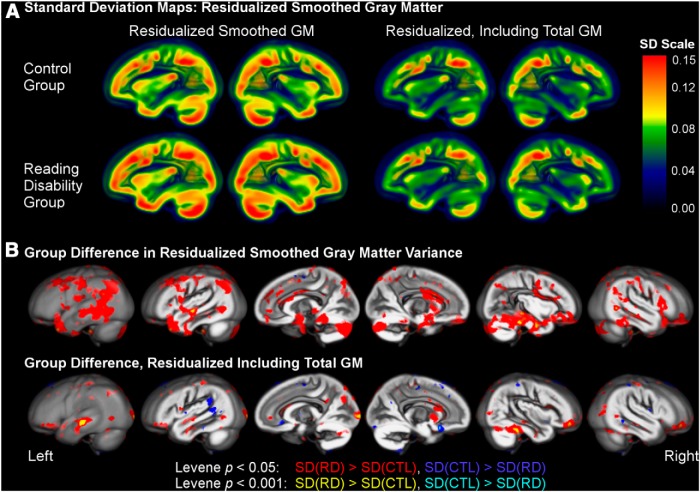
Gray matter variance in control and reading disability groups. A, Representative sections shows standard deviations across voxels for the smoothed gray matter images (residualized smoothed GM: after removing variance for gender, age, and research site; corrected for total GM: after removing variance for gender, age, research site and total gray matter volume). B, A voxelwise Levene test (uncorrected for multiple comparisions) demonstrated brain regions where there were reading disability group differences in gray matter variance [red: reading disability (RD) > control (CTL); blue: CTL>RD].